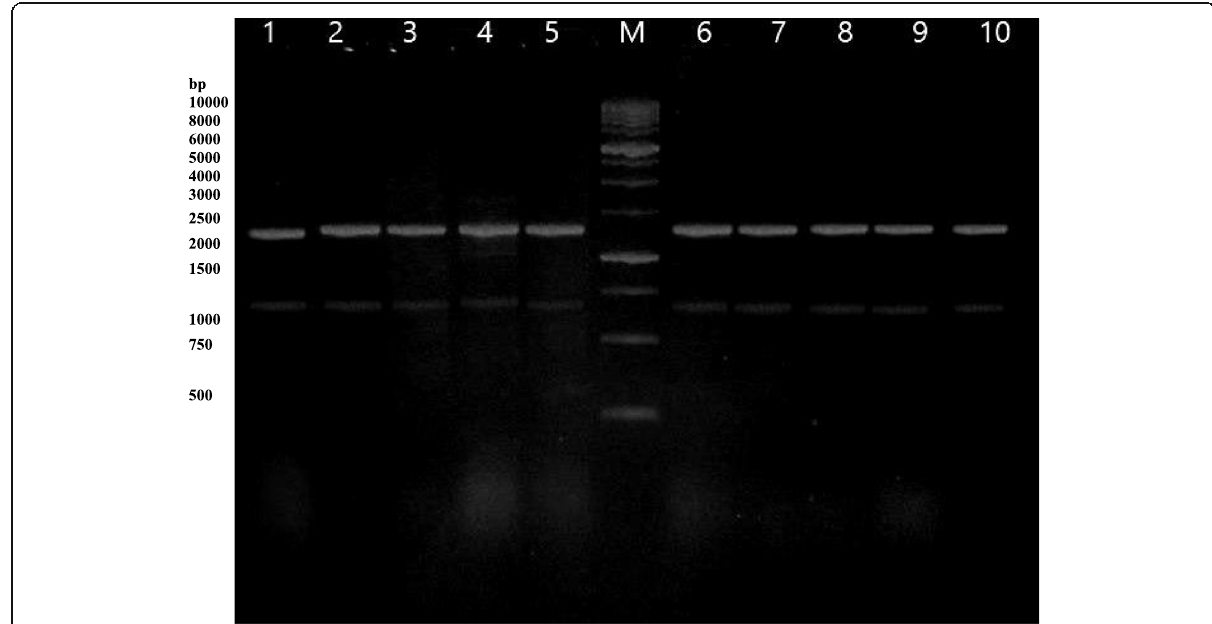
Fig. 2 RFLP patterns of OmpH DNA after digestion with restriction enzyme Msp I. Lanes 1 – 10 PCR product and M 1kbp DNA ladder